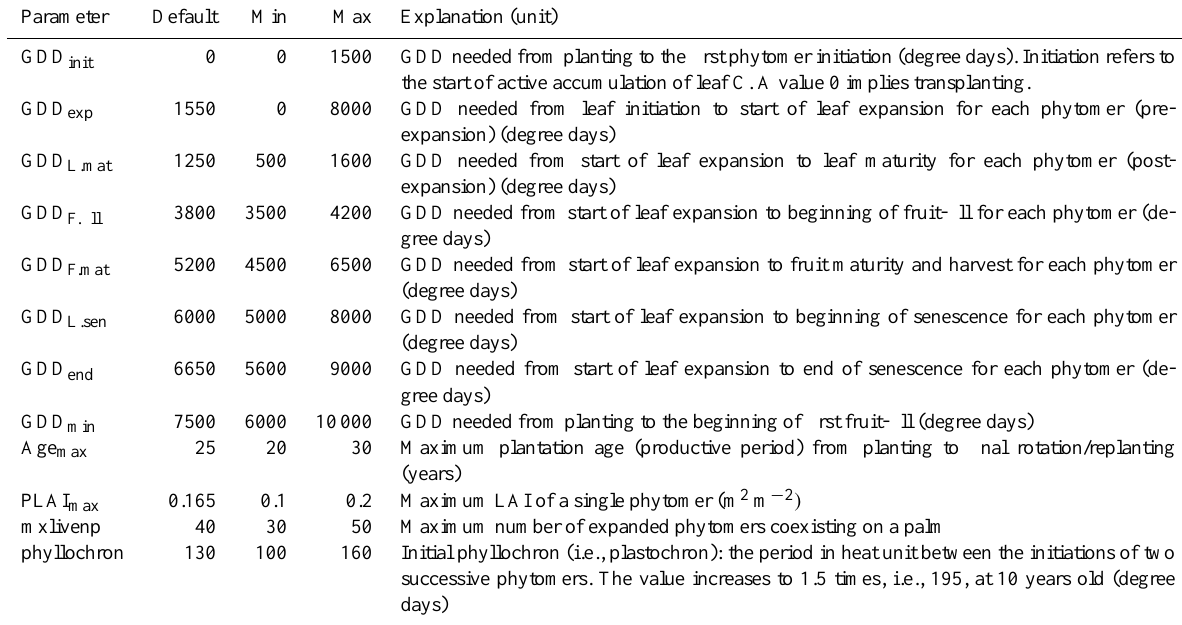
Table A1. Summary of new phenological parameters introduced for the phenology subroutine of CLM-Palm. The default values were determined by calibration and with reference to field observations and literature on oil palm (Combres et al., 2013; Corley and Tinker, 2003; Hormaza et al., 2012; Legros et al., 2009).